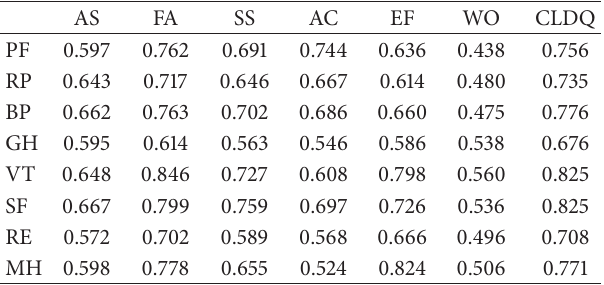
Table 4: Spearman’s rank correlations between CLDQ and SF-36 scales.